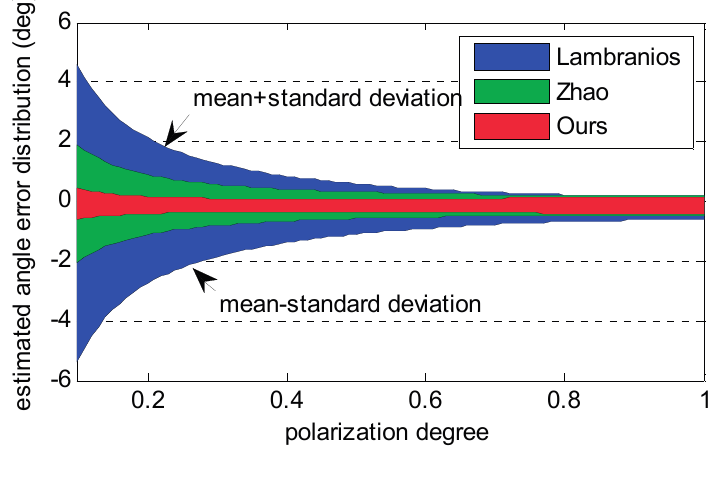
Figure 6. Angle estimation error comparison of different algorithm with different polarization